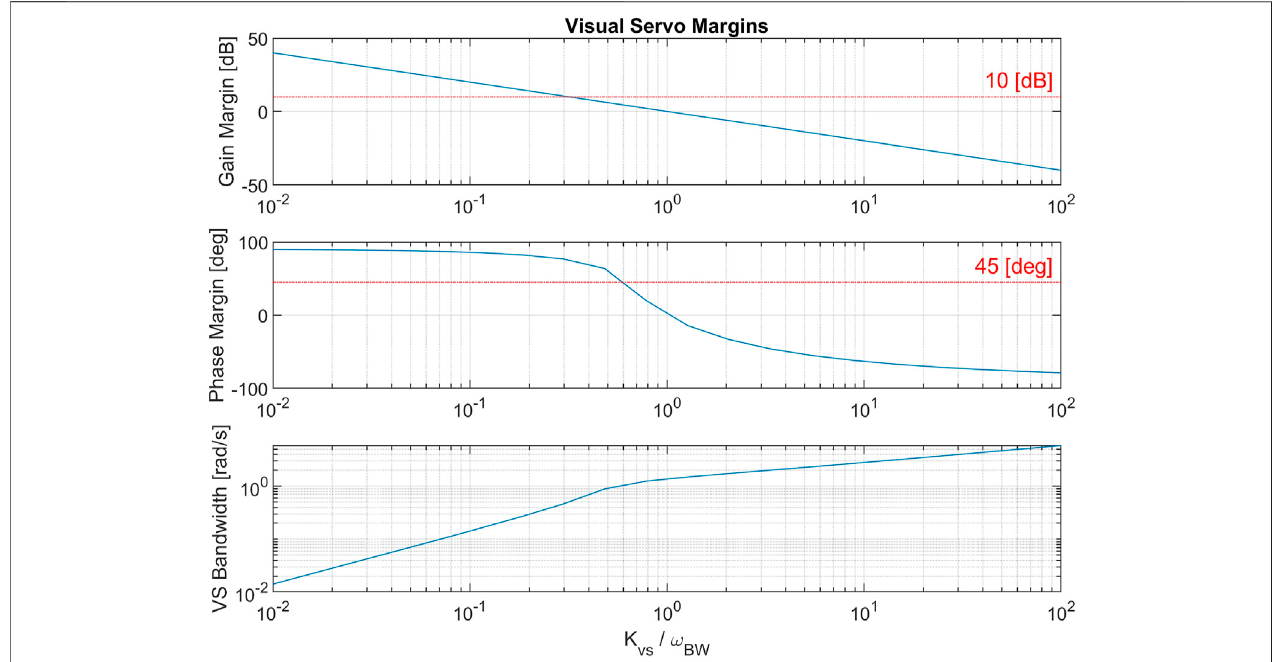
FIGURE 9 | A study of vision-based servo loop margins and bandwidth based on position gain K VS normalized by joint control bandwidth ω BW .